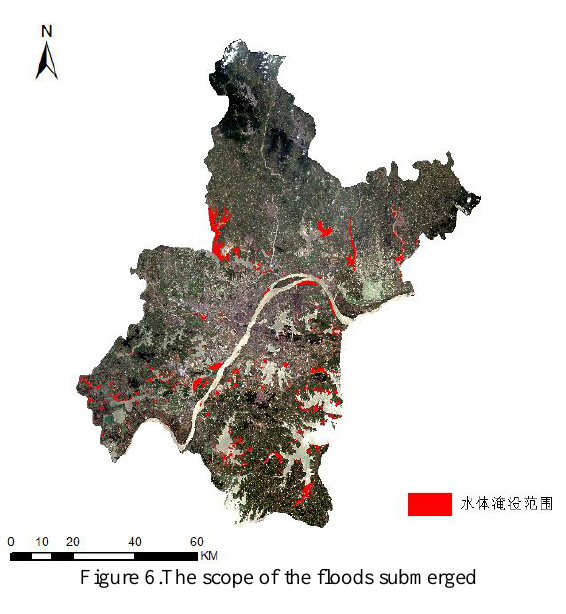
Figure 6.The scope of the floods submerged